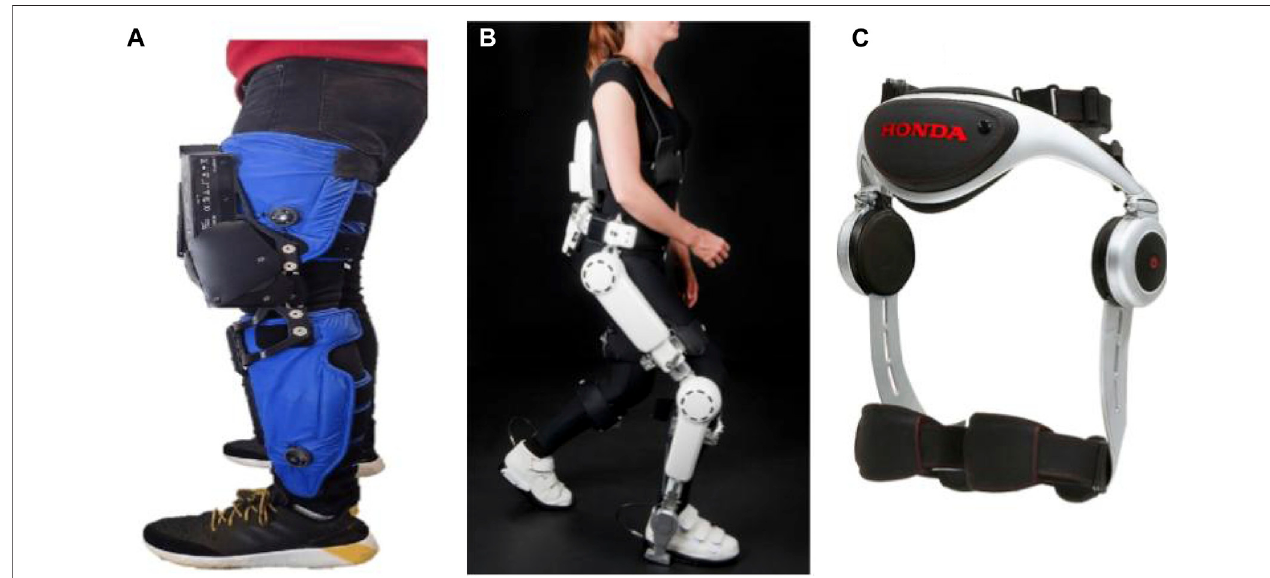
FIGURE 5 | Robotic devices for in-home walking training: (A) AlterG Bionic Leg (Wright et al., 2020), (B) HAL lower-limb exoskeleton (Anneli Nilsson et al., 2014), and (C) SMA (Buesing et al., 2015).